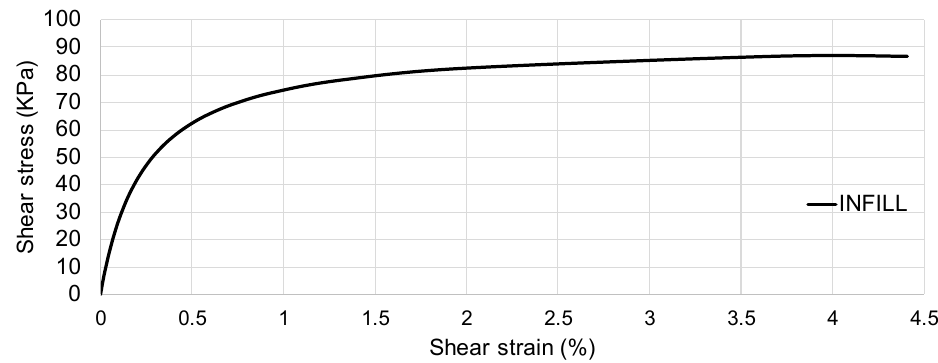
Figure 5. Backbone curve (Infill soil). Table 3. Mesh characteristics.